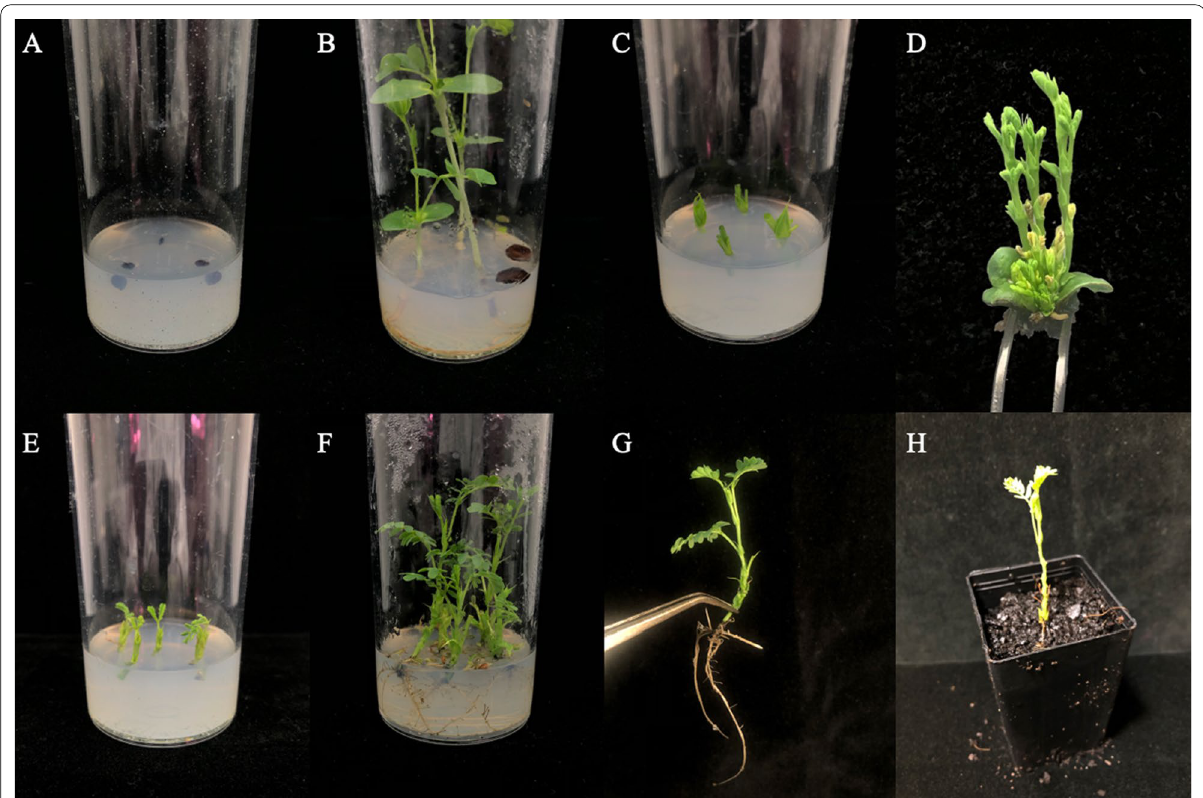
Fig. 4 Images of the various distinct stages in Neptunia amplexicaulis nodal micropropagation. A Seeds in media for germination, B seedlings after 4 weeks of growth, C Nodes from 4‑week‑old seedlings in multiplication media, D . Node displaying multiple shoots, E Elongated shoots in rooting media, F Rooted shoots in media, G Rooted shoot removed from media, H Acclimatised